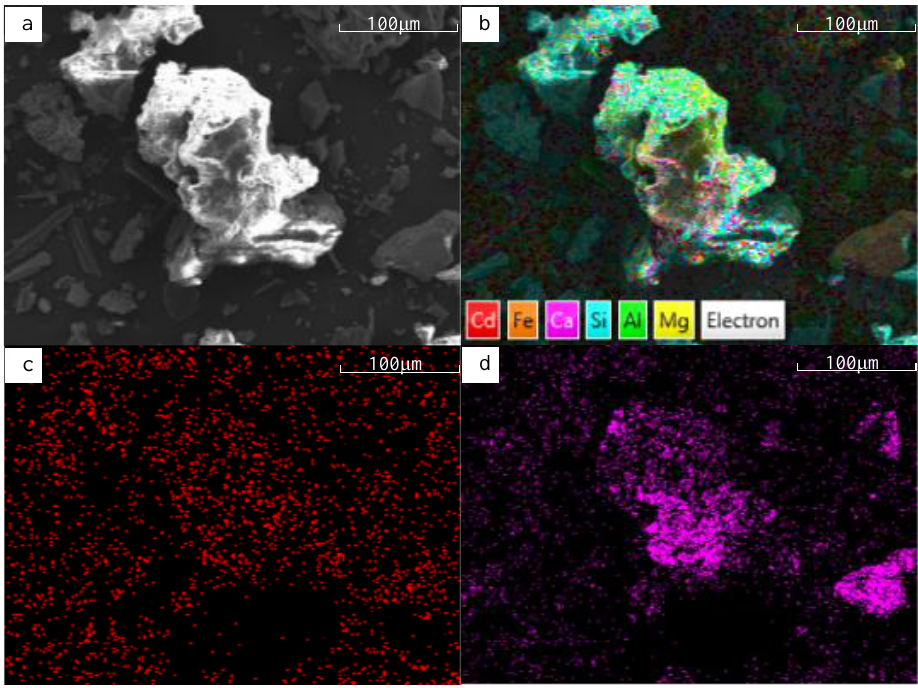
Figure 12. SEM of BFA-N after adsorbing Cd, ( a ) electron image, ( b ) EDS layered image, ( c ) Cd, ( d ) Ca.